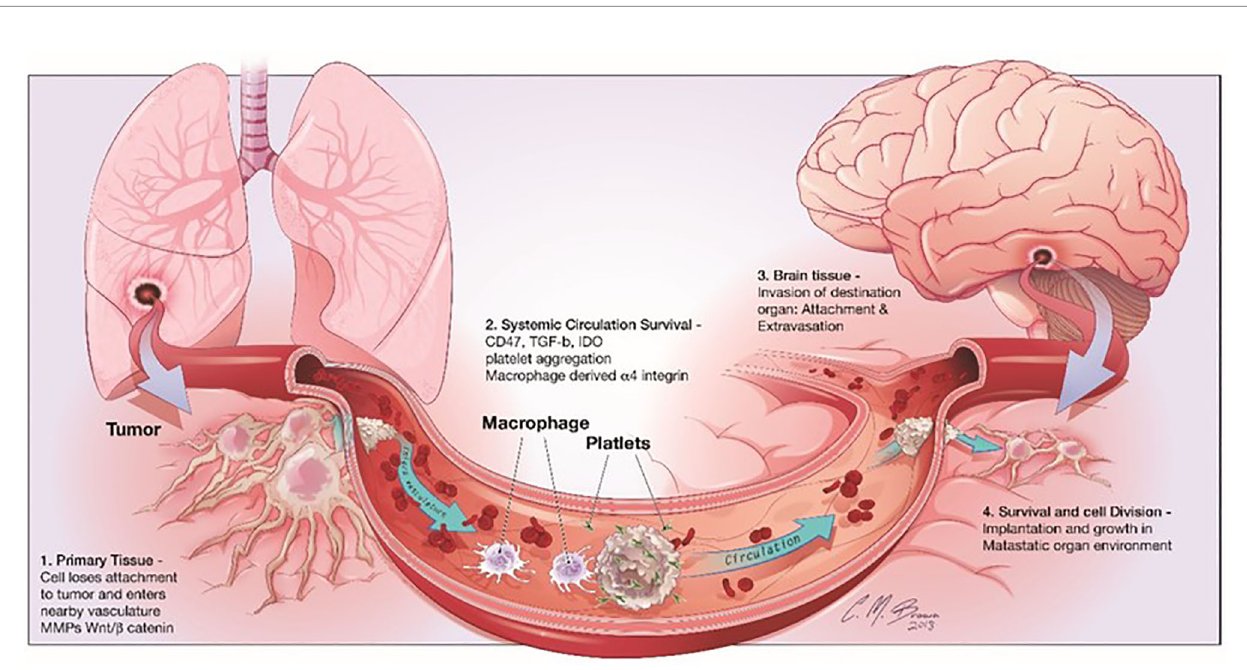
FIGURE 1 | Steps involved in brain metastasis. Brain metastasis cascade involves four major steps: 1) Detachment of the metastatic cell from the primary cancer, 2) Survival in systemic circulation, 3) Invasion in the brain parenchyma and 4) Survival in the CNS